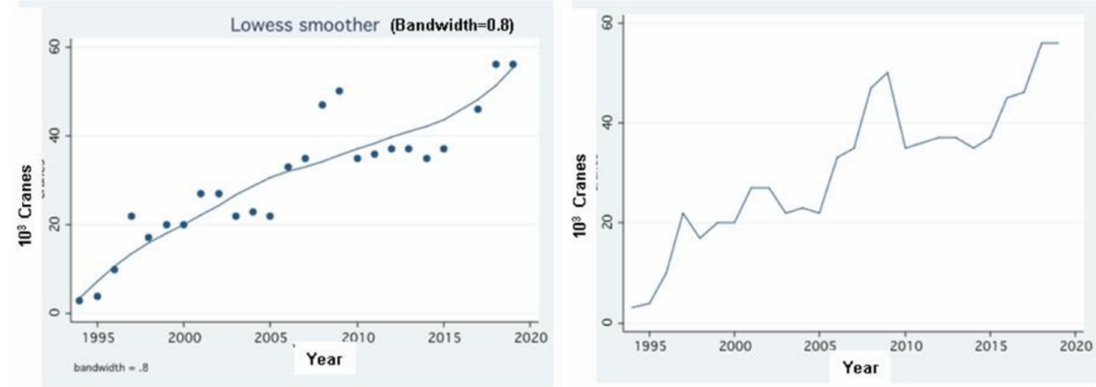
Figure 9. Temporal (1994–2018) changes in maximal counts of the wintering crane population in the Hula Valley. Left : LOWESS smoother plot (bandwidth = 0.8). Right : line